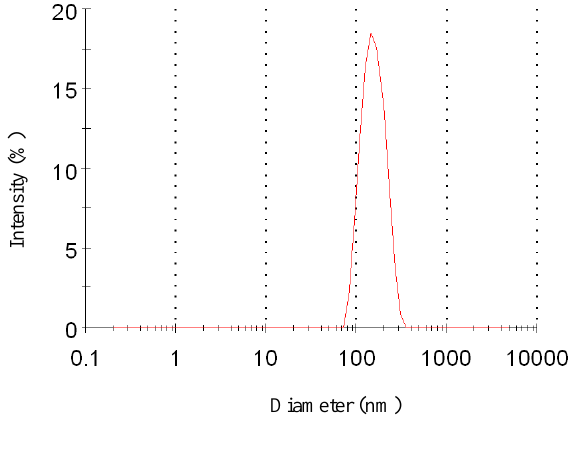
Figure 2. Particle size distribution of nanoparticles (12 MPa, 35 °C, 1.0 mg/mL, 1.0 mL/min).